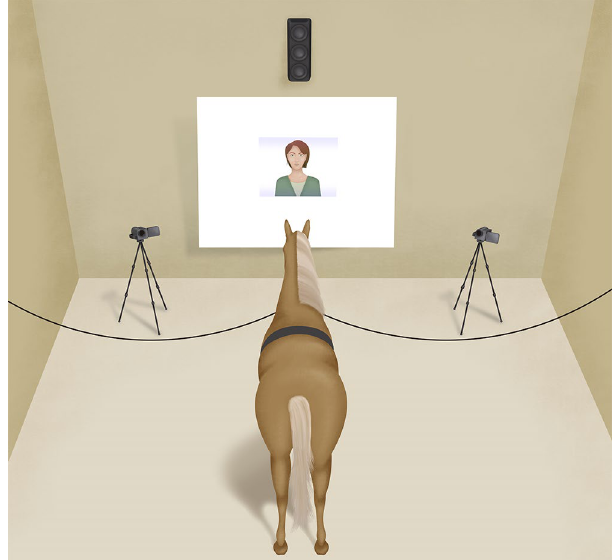
Figure 2. Schematic representation of the experimental